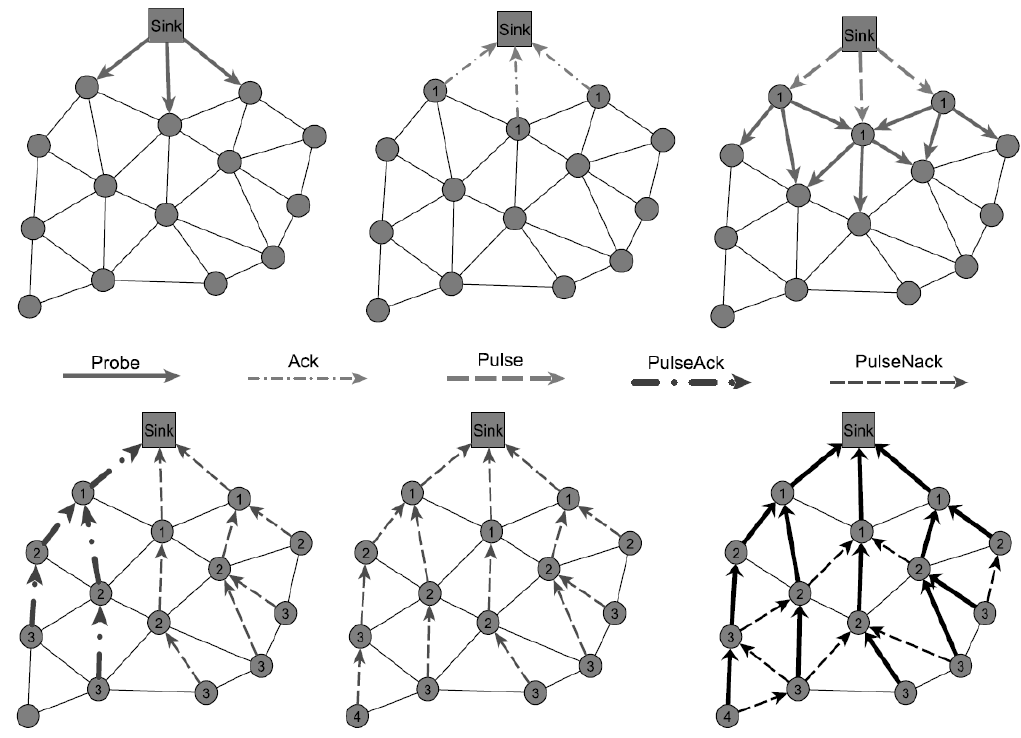
Figure 9. Process of shortest hop multi paths construction in SHM